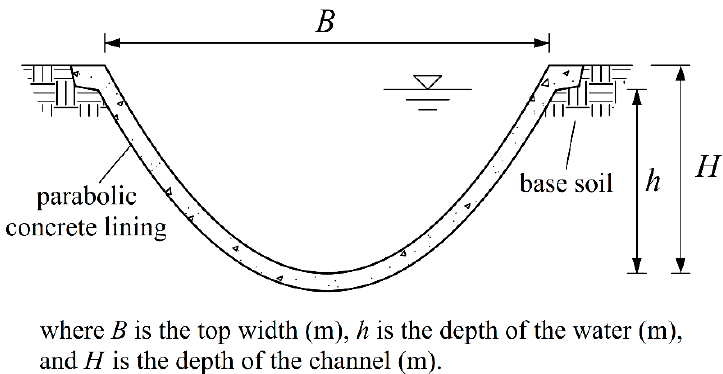
Figure 2. Schematic diagram of parabolic channel cross section.